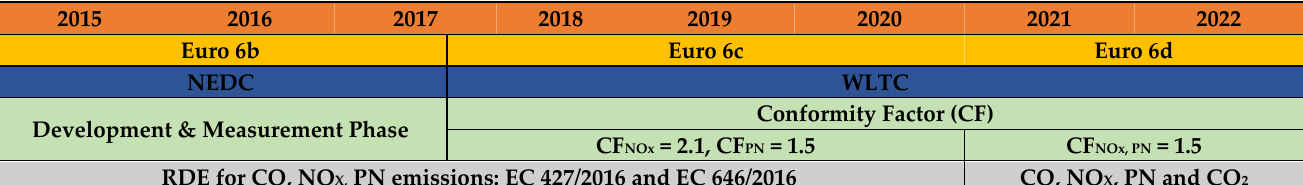
Table 4. Requirements for TA tests and real operating conditions for passenger vehicles in 2015–2022.